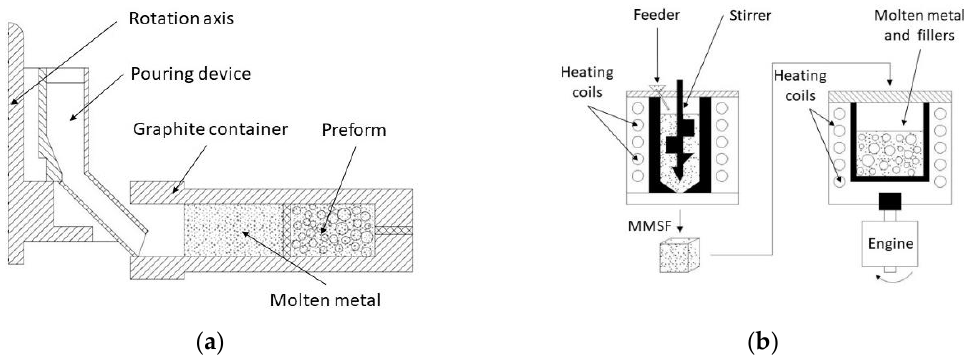
Figure 7. ( a ) Schematic representation of the centrifugal infiltration set-up adapted from Sugishita et al. [107]; ( b ) Centrifugal infiltration set-up adapted from Ferreira et al. [106].